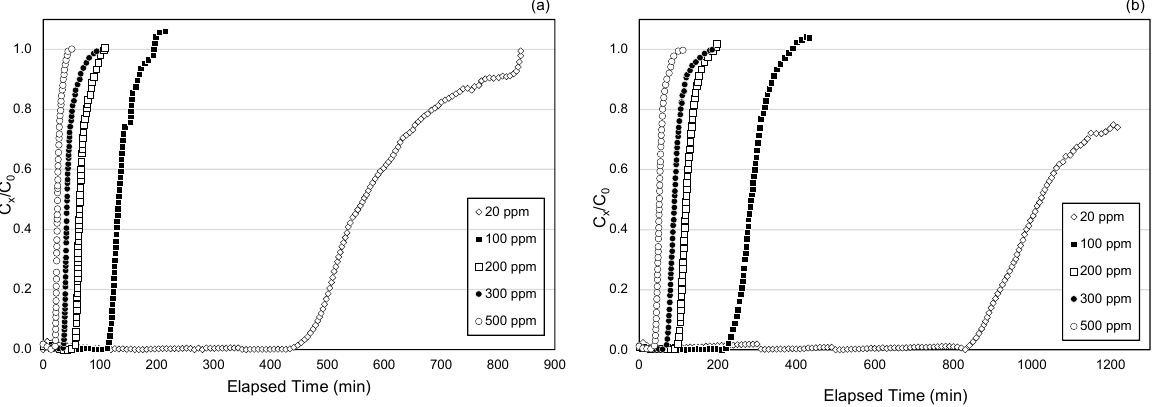
Figure 4. Breakthrough curves for ( a ) CS1 (100% AF1) and ( b ) CS6 (100% AF6) cartridge types by toluene concentration. Such an increase in breakthrough time, however, is not linear with the toluene con- centration. The breakthrough time increase at lower toluene concentrations was observed to be greater than that at higher concentrations, even at the same proportional change in toluene concentration. For example, the breakthrough time increase from 100 to 300 ppm toluene is larger compared to the time increase from 300 to 500 ppm toluene for CS1 and CS6 cartridge types, despite the same concentration increment of 200 ppm (Figure 4). Such a non-linear relationship between breakthrough times (10%, 50%, and 5 ppm) and toluene concentration was found for all cartridge types, as shown in Figure 5. Similar results were found in a previous ACF study that involved the testing of ACF samples against toluene for respirator application [26]. This finding indicates that the ACF cartridges may be more efficient in providing a longer service life at lower toluene concentrations, and may be attributed to the microporosity of the ACF adsorbents, because micropores in activated carbons are mainly responsible for the enhanced adsorption of vapors at low ambient concentrations and are favorably filled at low concentrations due to the overlapping of attractive forces associated with the close proximity of the opposite pore walls [32–34]. A study by Fuertes et al. [35] found that the adsorbate amount at low concentrations de- pends on the pore size distribution of the adsorbent, specifically, its microporosity, which allows higher adsorption capacities at low concentrations. Evidence has shown the im- portance of narrow microporosity in ACF materials in optimizing VOC adsorption at low concentrations